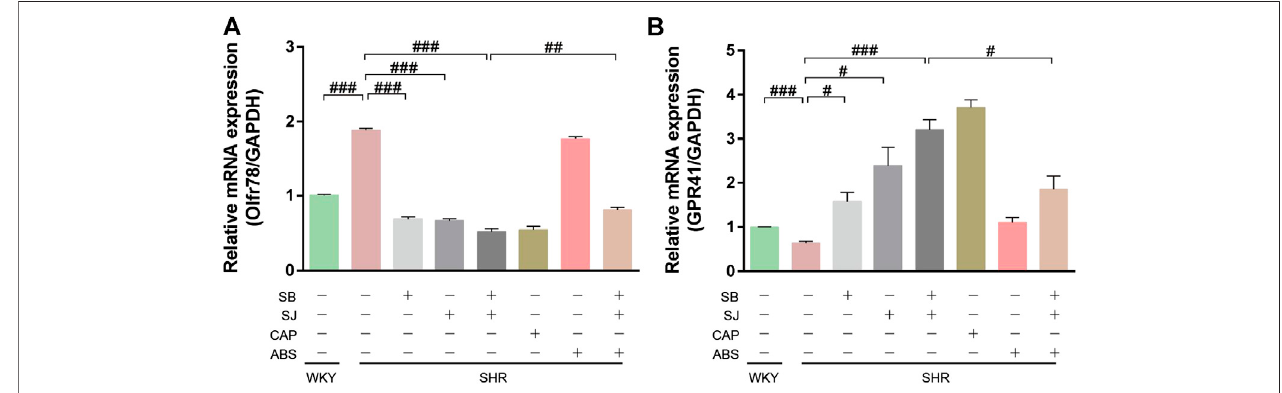
FIGURE 8 | Short-chain fatty acid receptors are altered in the kidneys of SHR. (A) The mRNA expression of Olfr78. (B) The mRNA expression of GPR41. ### p < 0.001. ## p < 0.01. # p < 0.05.